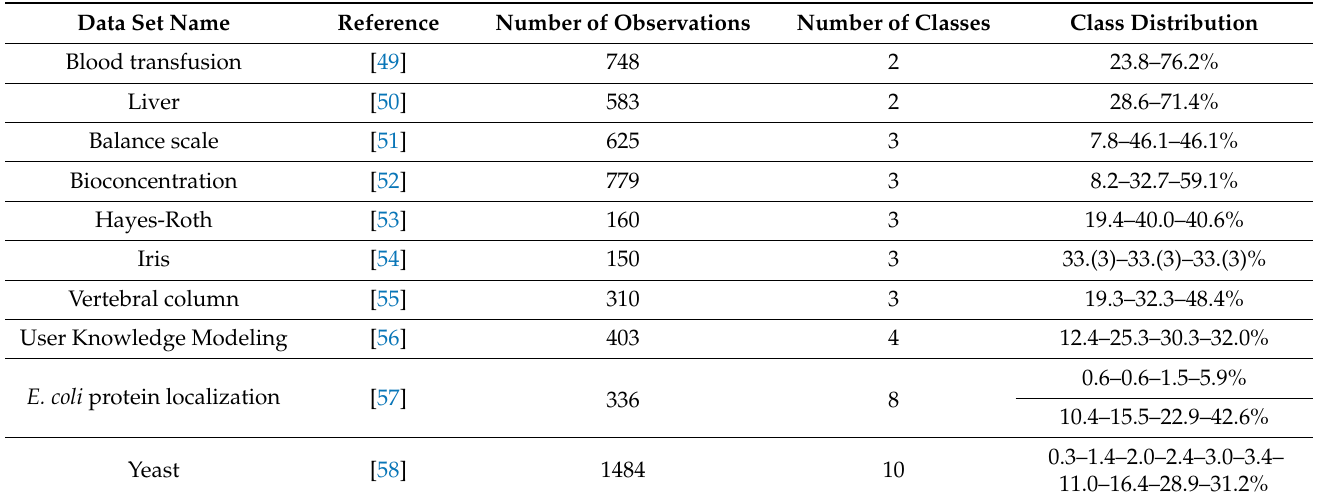
Table 1. Data sets characteristics.